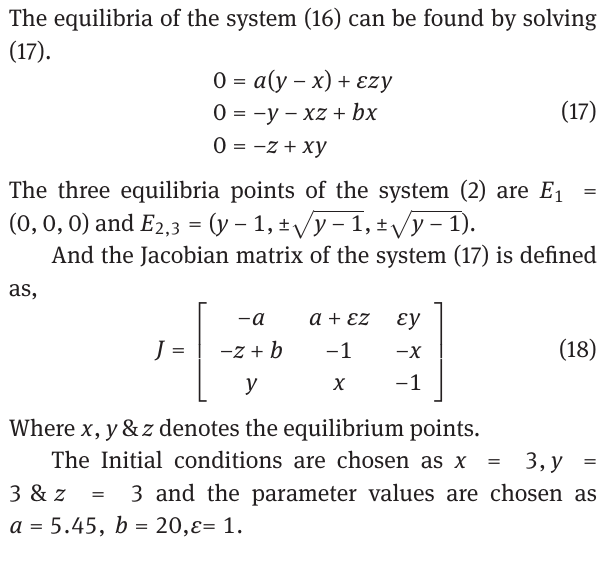
Fig. 4: Bifurcation of Quadrature axis versus ‘ b ’ and Direct axis current versus ‘ b